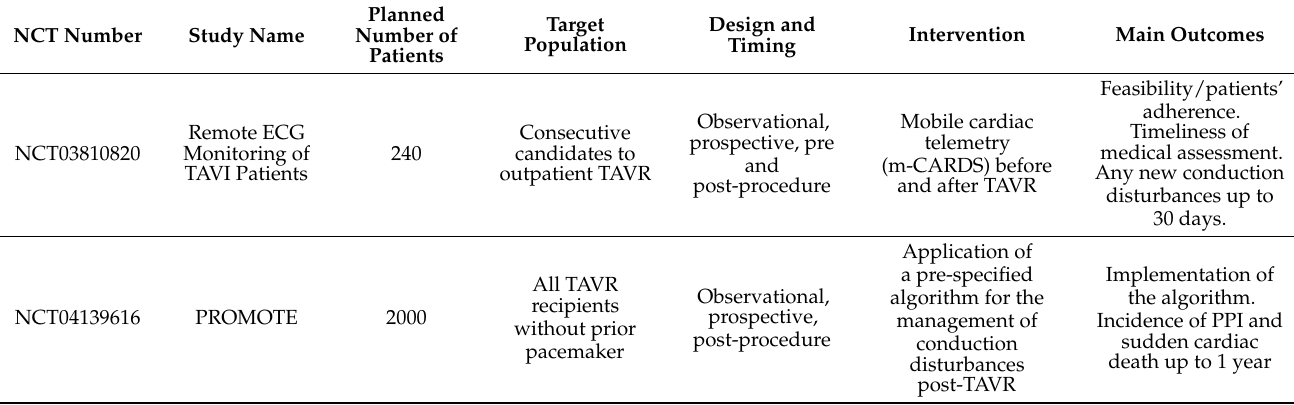
Table 1. Ongoing studies regarding conduction disturbances in the setting of transcatheter aortic valve